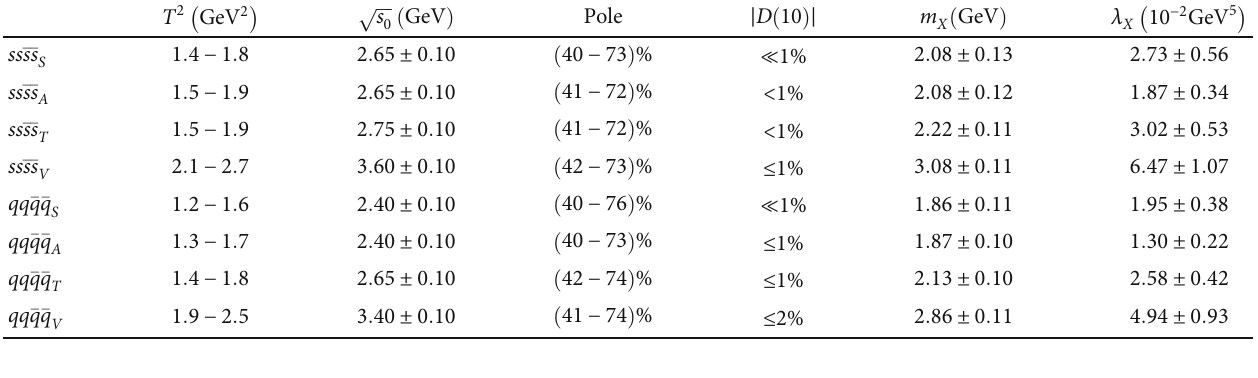
Table 1: The Borel parameters, continuum threshold parameters, pole contributions, contributions of the vacuum condensates of dimension 10, masses, and pole residues of the tetraquark states, where the subscripts S , A , T , and V denote the scalar, axialvector, tensor, and vector tetraquark states, respectively.